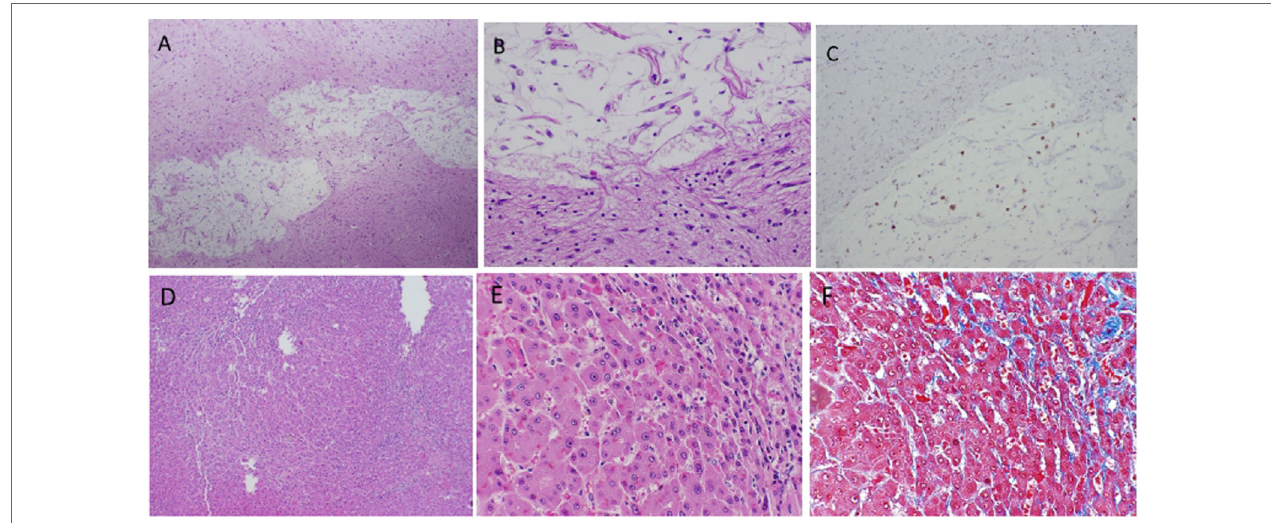
FIGURe 3 | Infarcted lesion in basal ganglia (a–C) . (a) Cavity lesion with residual histiocytes and adjacent dense astrocytosis (4 × 10 magnification). (B) Same lesion at 20 × 10 magnification. (C) KP1 stain highlights histiocytes within cavity (4 × 10 magnification). Hepatic findings (D–F) . Nodular regenerative hyperplasia (NRH) shows in (a) (4 × 10) and (B) (20 × 10). Mild sinusoid fibrosis is seen in areas of NRH demonstrated by Trichrome Masson stain (C) (20 ×